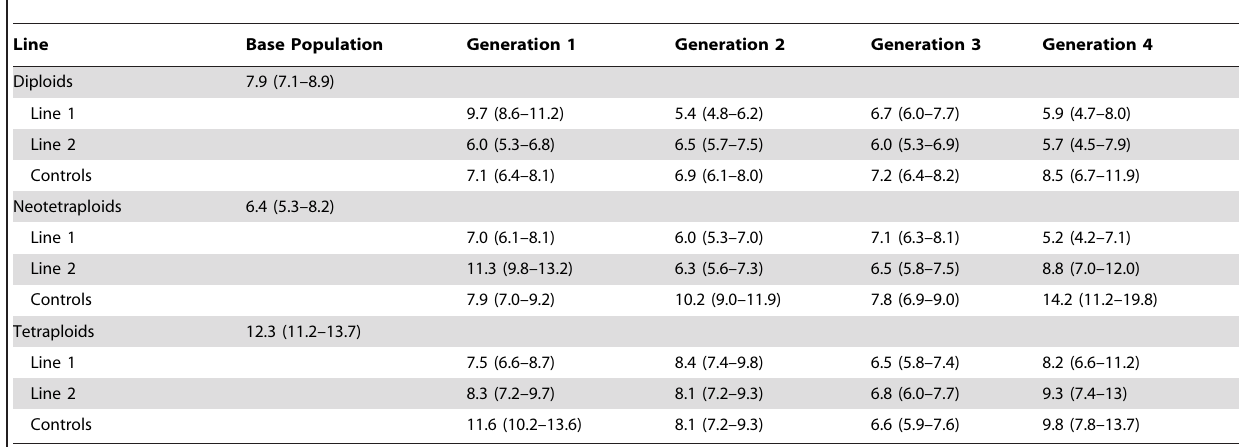
Table 4. Coefficent of variation in flowering time by generation for each line with 95% confidence